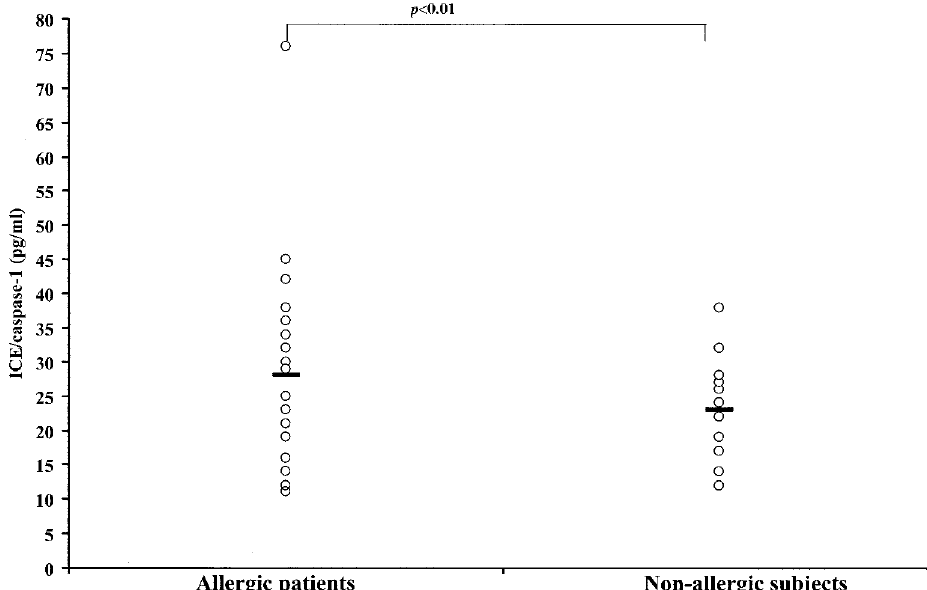
FIG. 5. ICE/caspase-1 levels in serum of allergic patients and non-allergic subjects. (–) mean